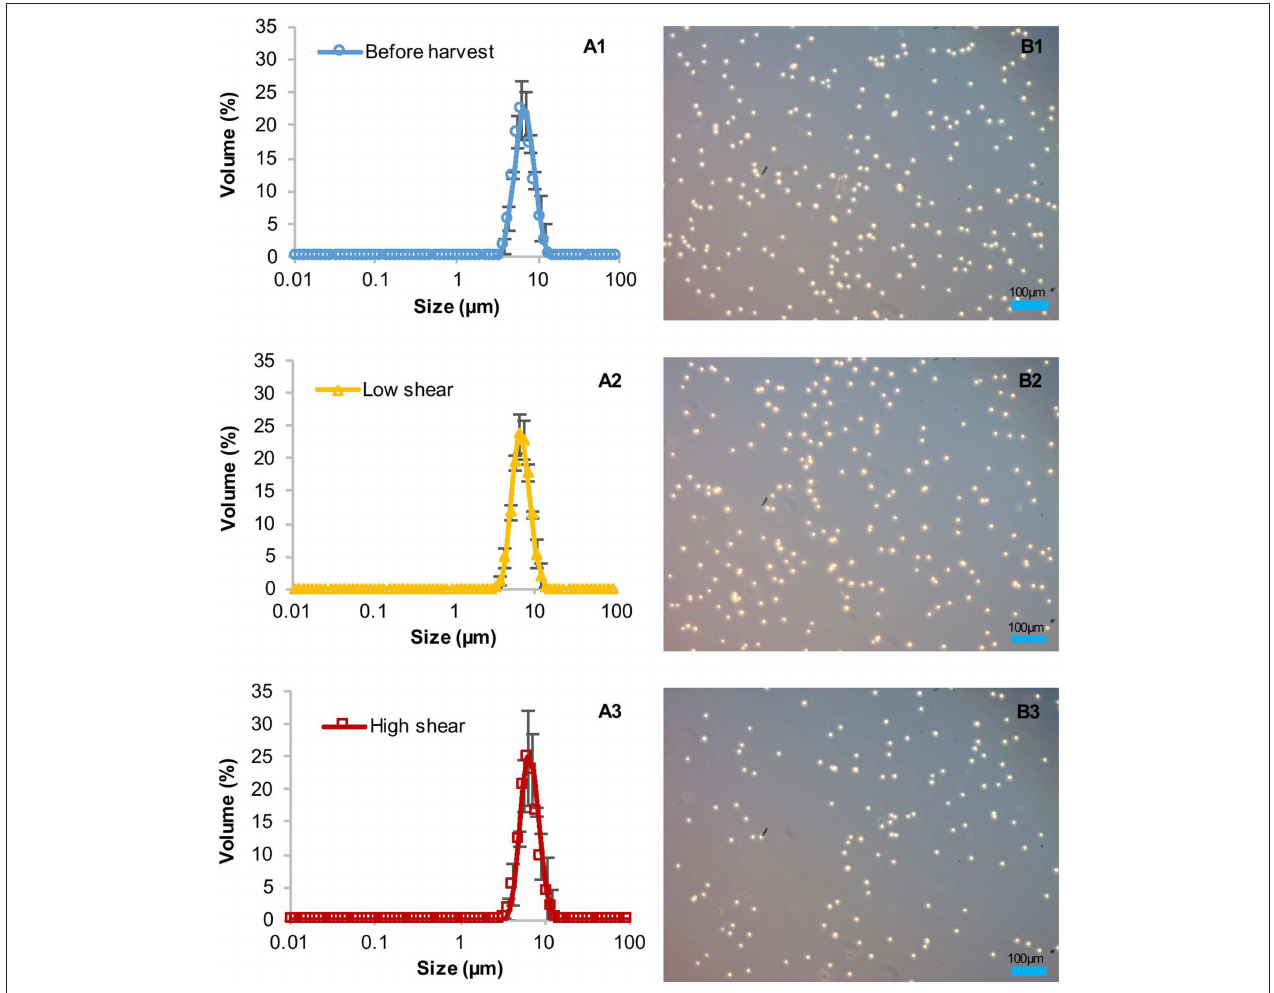
FIGURE 5 | Integrity of Chlamydomonas reinhardtii TN72_pal cells before and after ultra scale-down (USD) centrifugation. For the USD centrifugation studies, cells from two pilot-scale bag cultures were exposed to two levels of shear in the rotating shear device followed by bench-scale centrifugation at equivalent settling area. The cell integrity was determined by particle size measurements (A1–A3) and light microscopy (B1–B3) . Error bars represent ± 1 SD (n ≥